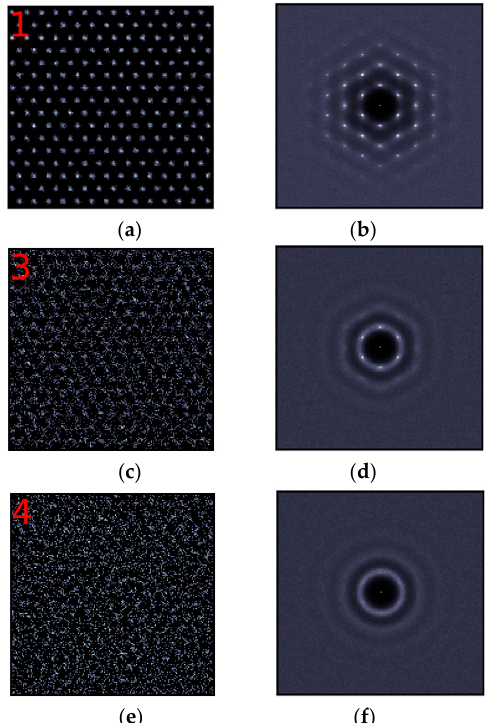
Figure 4. In ‐ plane ordering in the (111) interfacial layers. Left panel ( a , c , e ): 2 ‐ D density maps. The red Figure 4. In-plane ordering in the (111) interfacial layers. Left panel ( a , c , e ): 2-D density maps. The red numbers correspond to those defined in Figure 1. Right panel ( b , d , f ): 2 ‐ D structure factors for the numbers correspond to those defined in Figure 1. Right panel ( b , d , f ): 2-D structure factors for the corresponding layers. corresponding